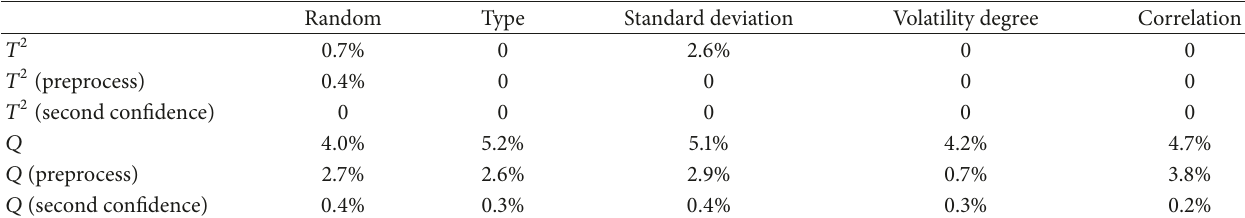
Table 1: False alarm probability of 𝑇 2 and 𝑄 statistics in 5 PCA